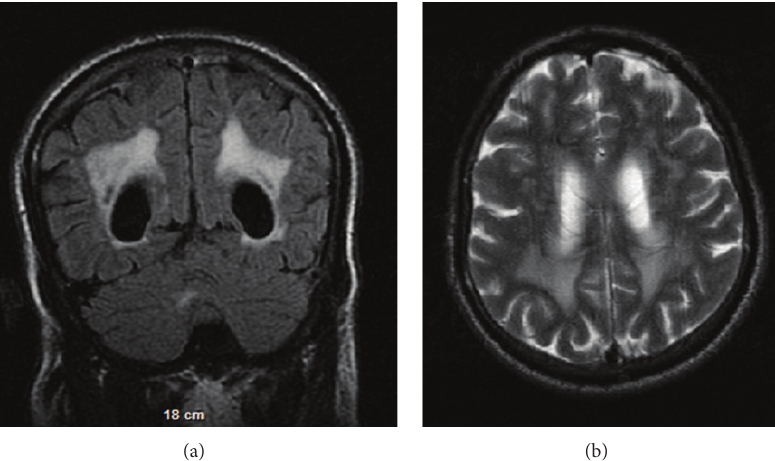
Figure 3: Patient number 19: a 46-year-old man with severity score 18. (a) Coronal FLAIR image shows bilateral dense parietal and occipital hyperintensities, confluent in the posterior periventricular areas and significant enlargement of ventricles. (b) Axial T2W image demonstrates round subcortical bilateral frontal white matter hyperintensities and significant enlargement of ventricles and subarachnoid spaces (severity of brain atrophy: 3